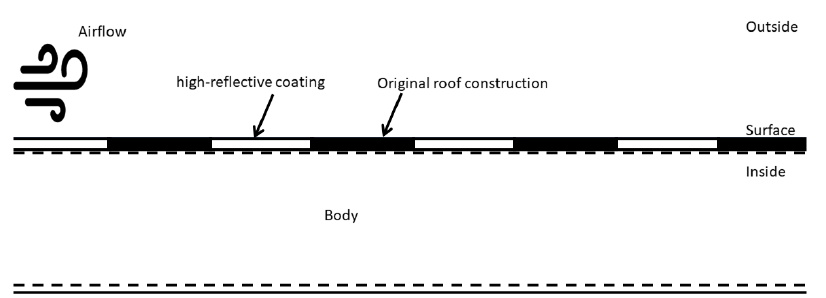
Figure 8. The 2D heat transfer transient setup to evaluate the contrasted stripes strategy. Own